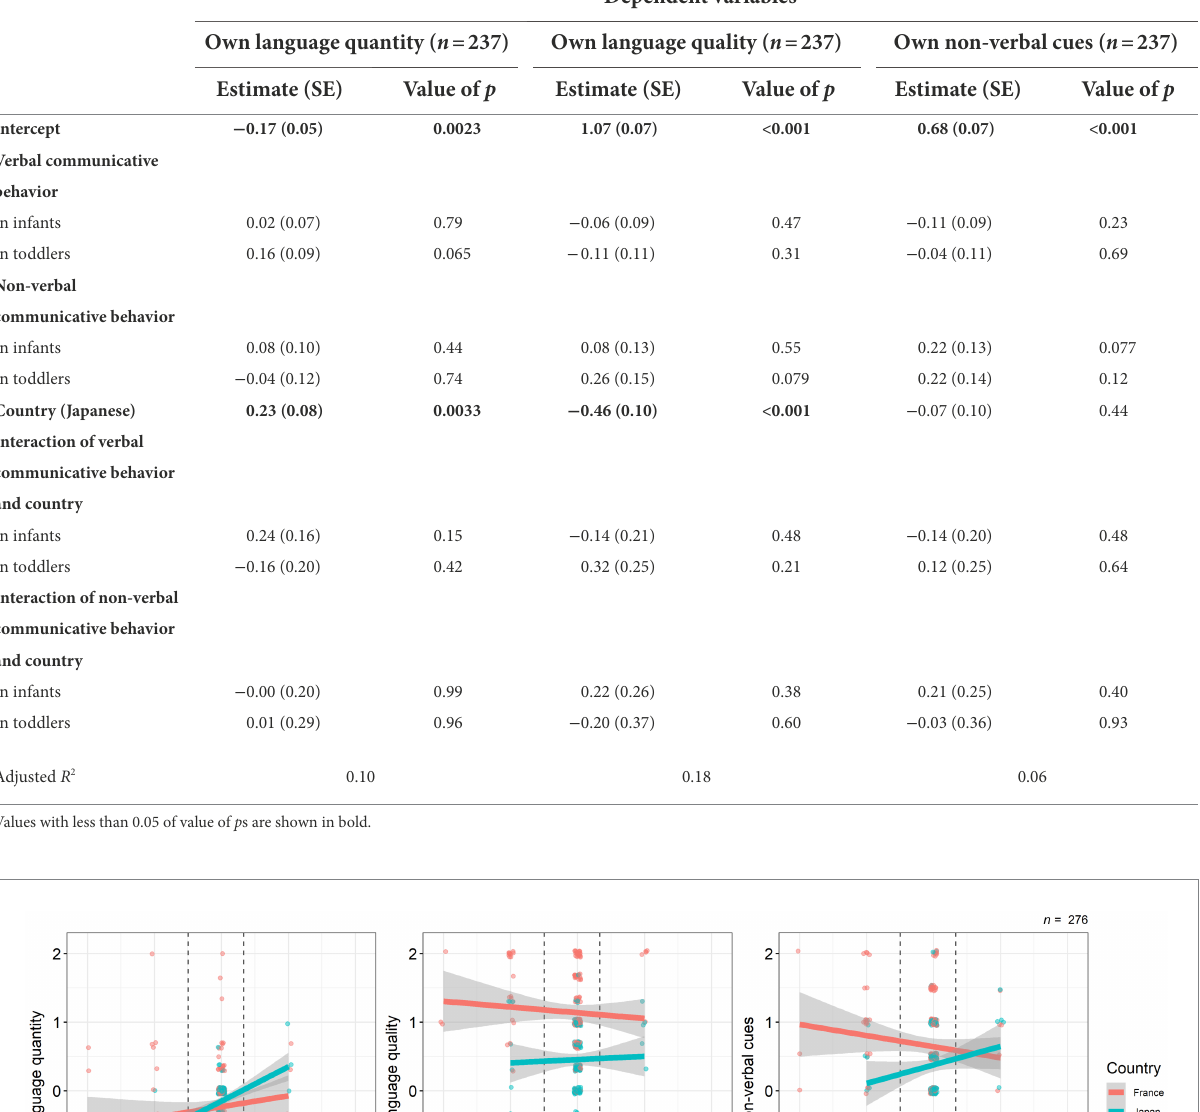
TABLE 4 The linear regression models predicting educators’ own communicative behavior toward children.